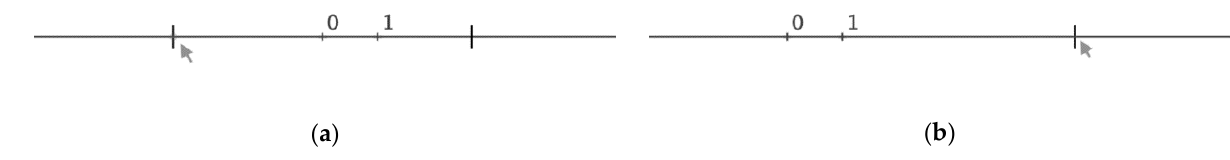
Figure 2. Two screenshots of the DGp of the function f ( x ) = | x | . The mouse cursor identifies the tick representing the independent variable, which is the only draggable one. ( a ) A screenshot of the DGp for a negative x -value; ( b ) A screenshot of the DGp for a positive x -value.